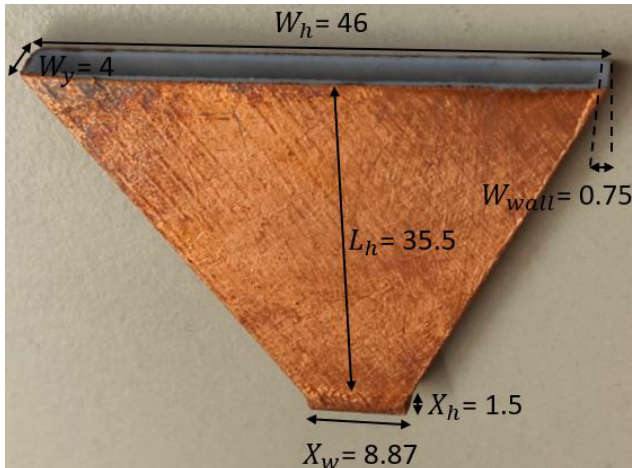
Figure 5. Horn antenna (all dimensions in mm).